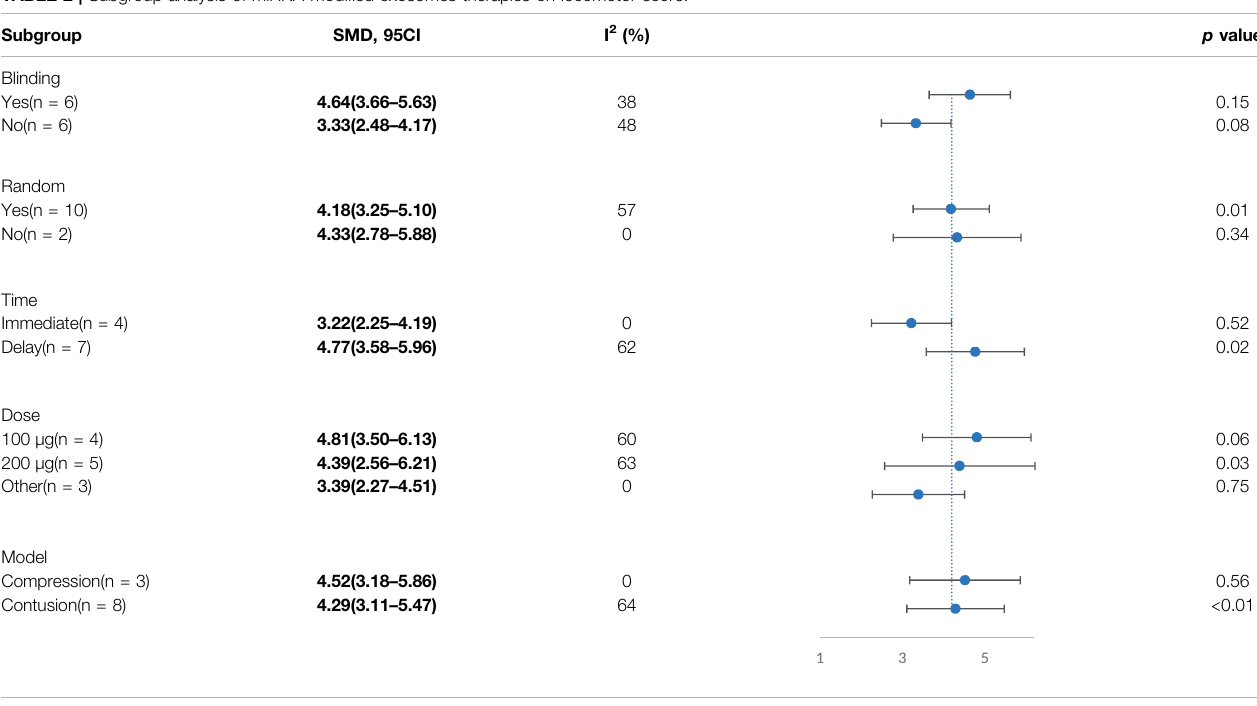
TABLE 2 | Subgroup analysis of miRNA-modi fi ed exosomes therapies on locomotor score.